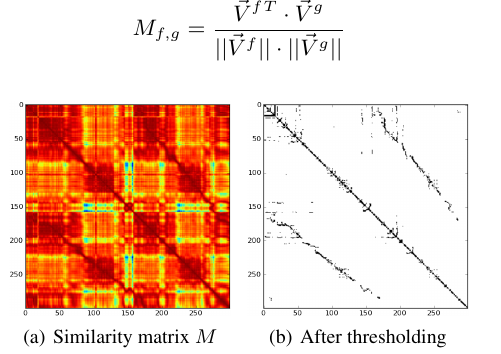
Figure 3: Similarity matrix for VDA.